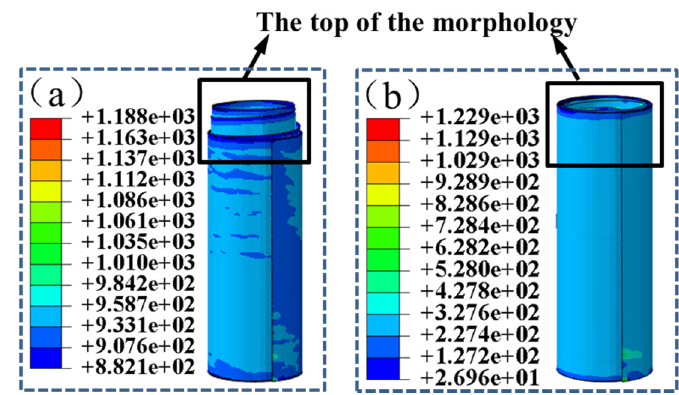
Figure 8. The effect of friction coefficients on the top morphology of the spring reel when ( a ) µ = 0.009; Figure 8. The e ff ect of friction coe ffi cients on the top morphology of the spring reel when ( a ) µ = 0.009; ( b ) µ = 0.025, 0.05, 0.1, and 0.3. ( b ) µ = 0.025, 0.05, 0.1, and